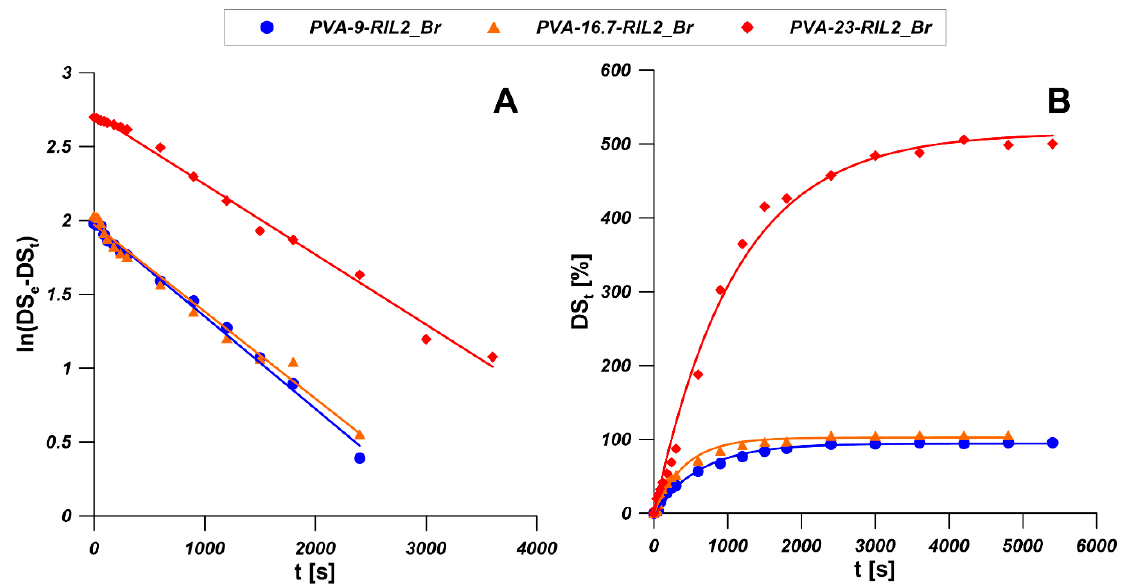
Figure 13. Experimental data of water sorption on PVA-RIL2_Br membranes fitted by linear ( A ) and non-linear ( B ) forms of PFO kinetic model.